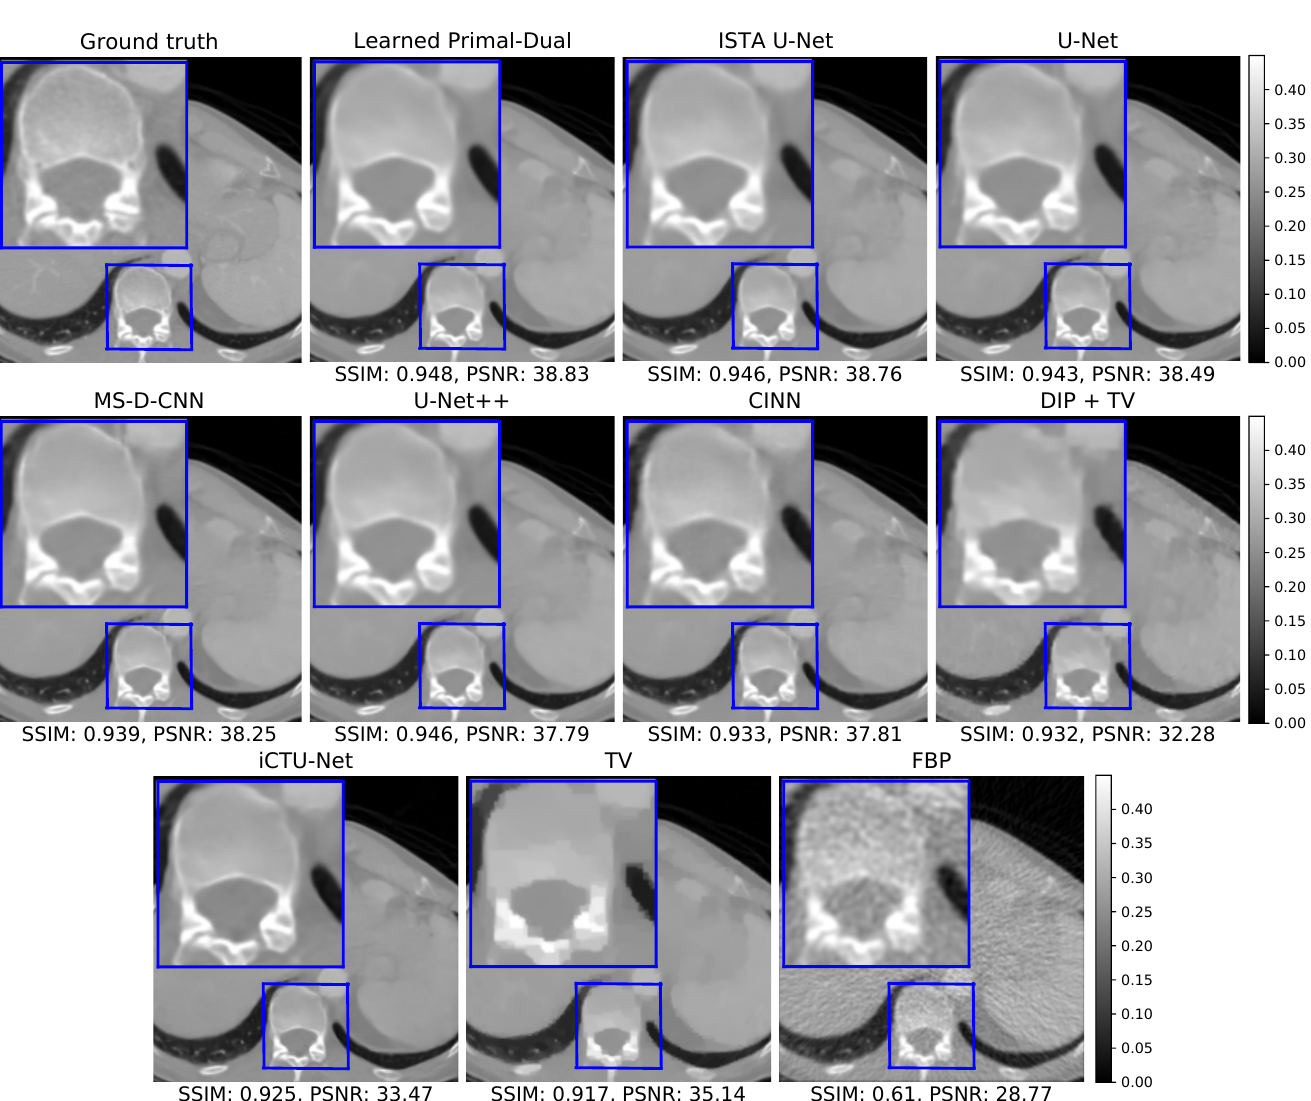
Figure 4. Reconstructions on the challenge set from the LoDoPaB-CT dataset. The window [ 0,0.45 ] corresponds to a HU range of ≈ [ − 1001, 831]